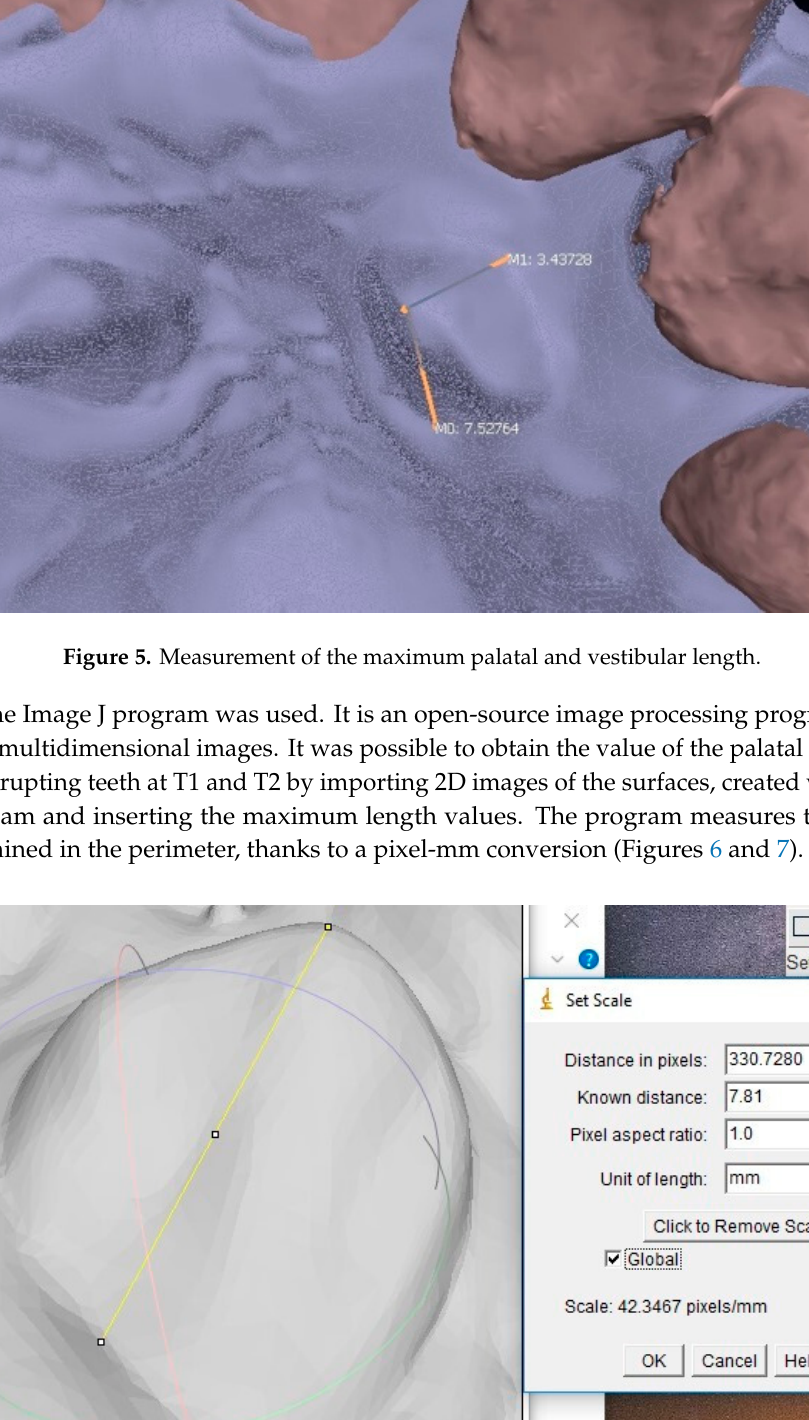
Figure 6. Tracing of maximum length of the palatal surface and setting of the scale of conversion.